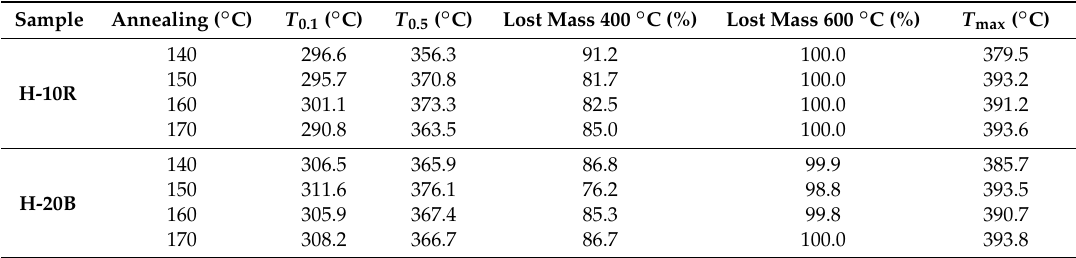
Table 9. Thermogravimetric results for blends prepared with the PP random and heterophasic copolymers after four different annealing